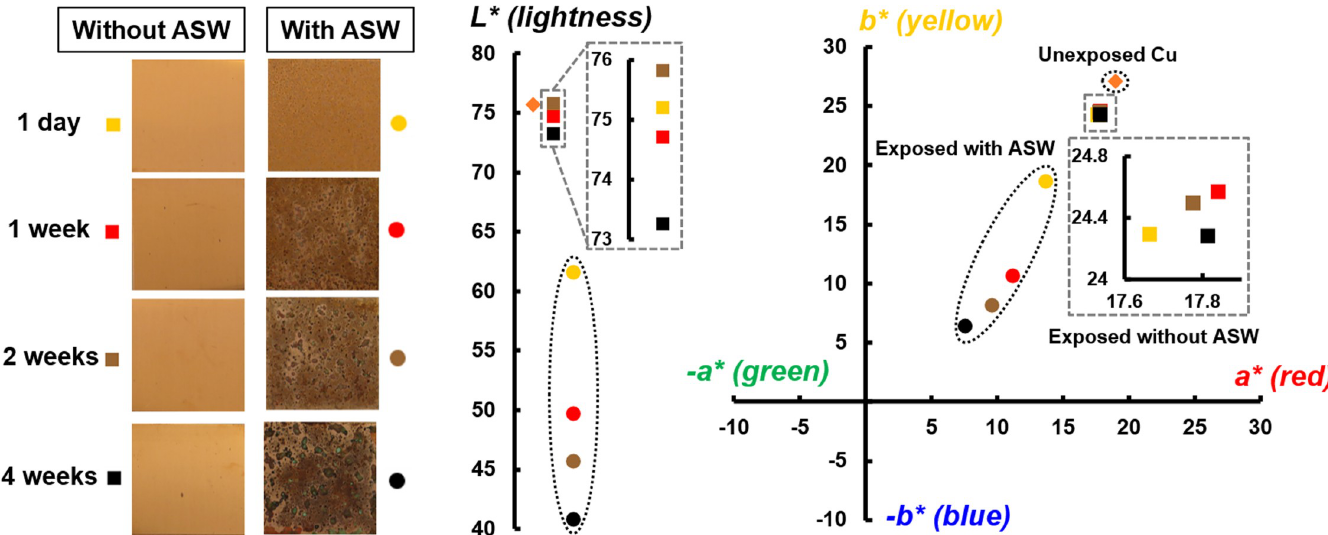
Fig 6. Changes in surface appearance (CIELab color reference space) of Cu metal with and without deposited ASW after climatic chamber exposure at daily repeated dry/wet periods for 1 day, 1, 2 and 4 weeks.